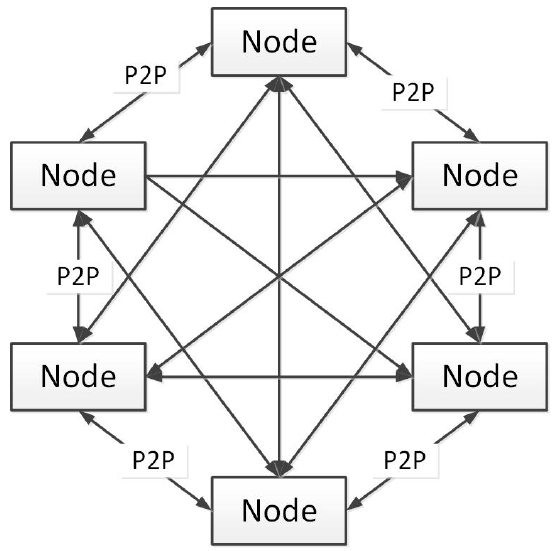
Figure 4. Structure of a single